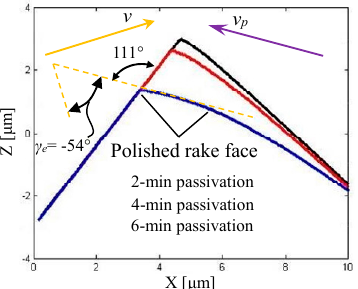
Figure 13. Large-size 2D scan results of the cutting edge after different passivation times ( v p represents the soft pad velocity, v represents the tool cutting velocity).